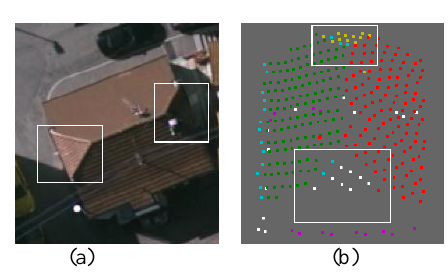
Figure 3. Profile of roof in Figure 2(a).